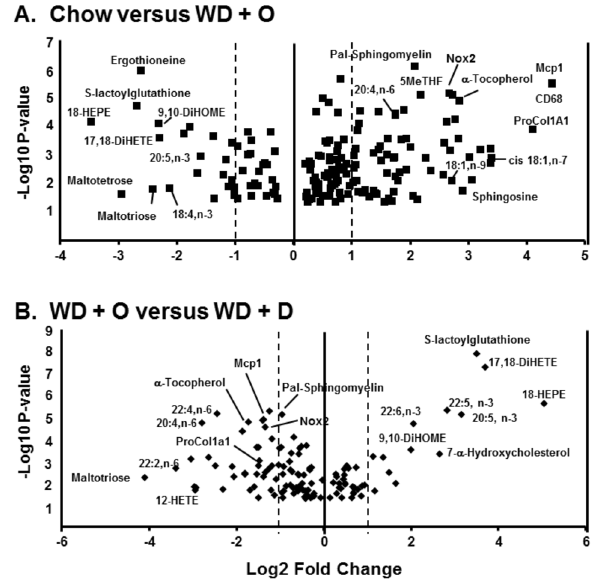
Figure 3. Volcano plots of diet effects on hepatic metabolites. Volcano plots were prepared using MetaboAnalyst (http://www.metaboanalyst.ca). The following groups (8 mice/group) were examined, Panel A: Chow versus WD + O; Panel B: WD + O versus WD + D. Results were plotted as log2 fold-change versus -log10 p-value. Several metabolites are labeled in each plot. doi: